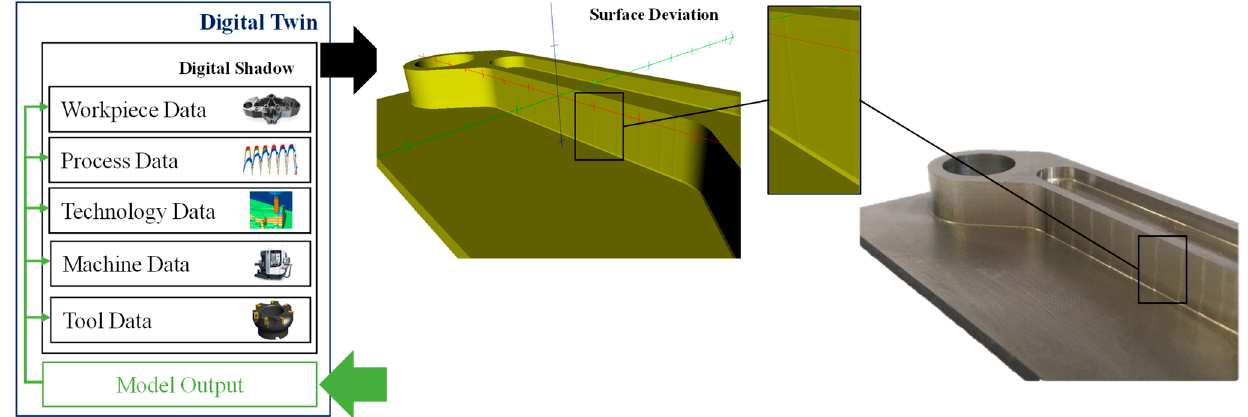
Figure 8. Illustration of surface deviations on the digital representation of the workpiece and the real component.